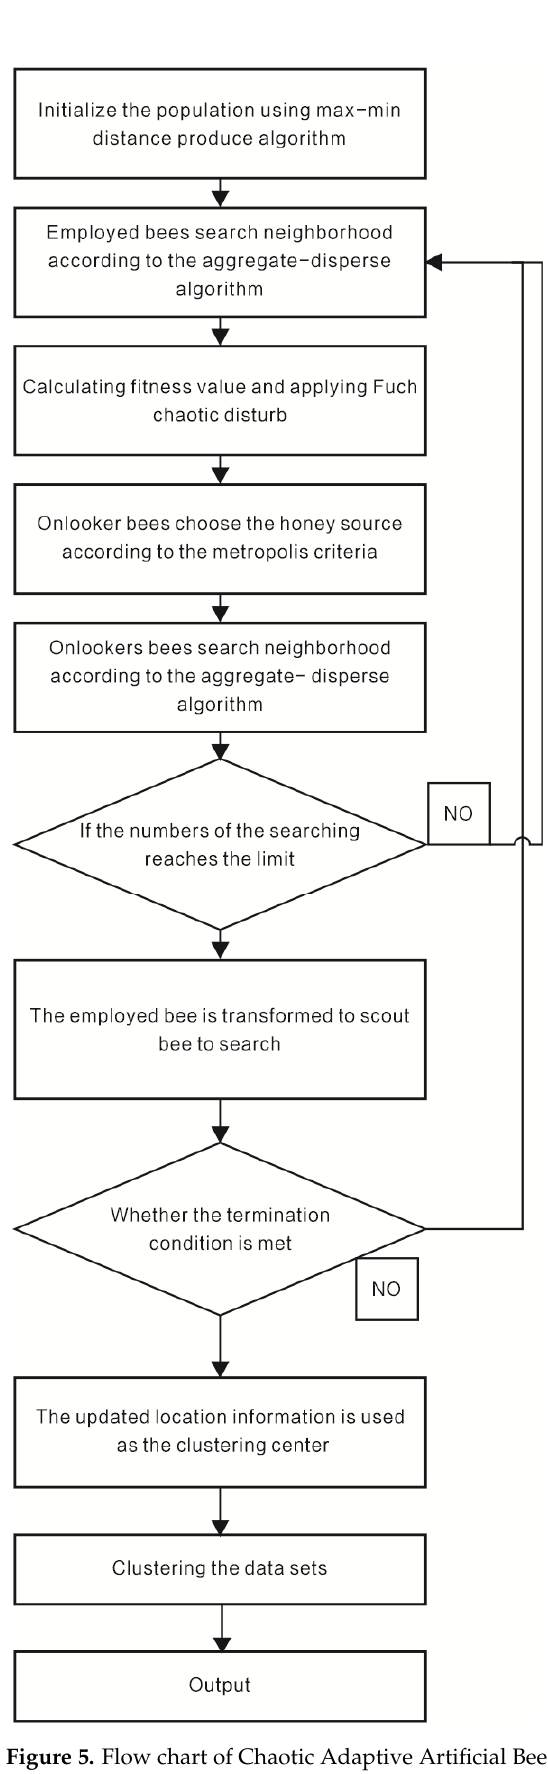
Figure 5. Flow chart of Chaotic Adaptive Artificial Bee Colony-Kmeans.